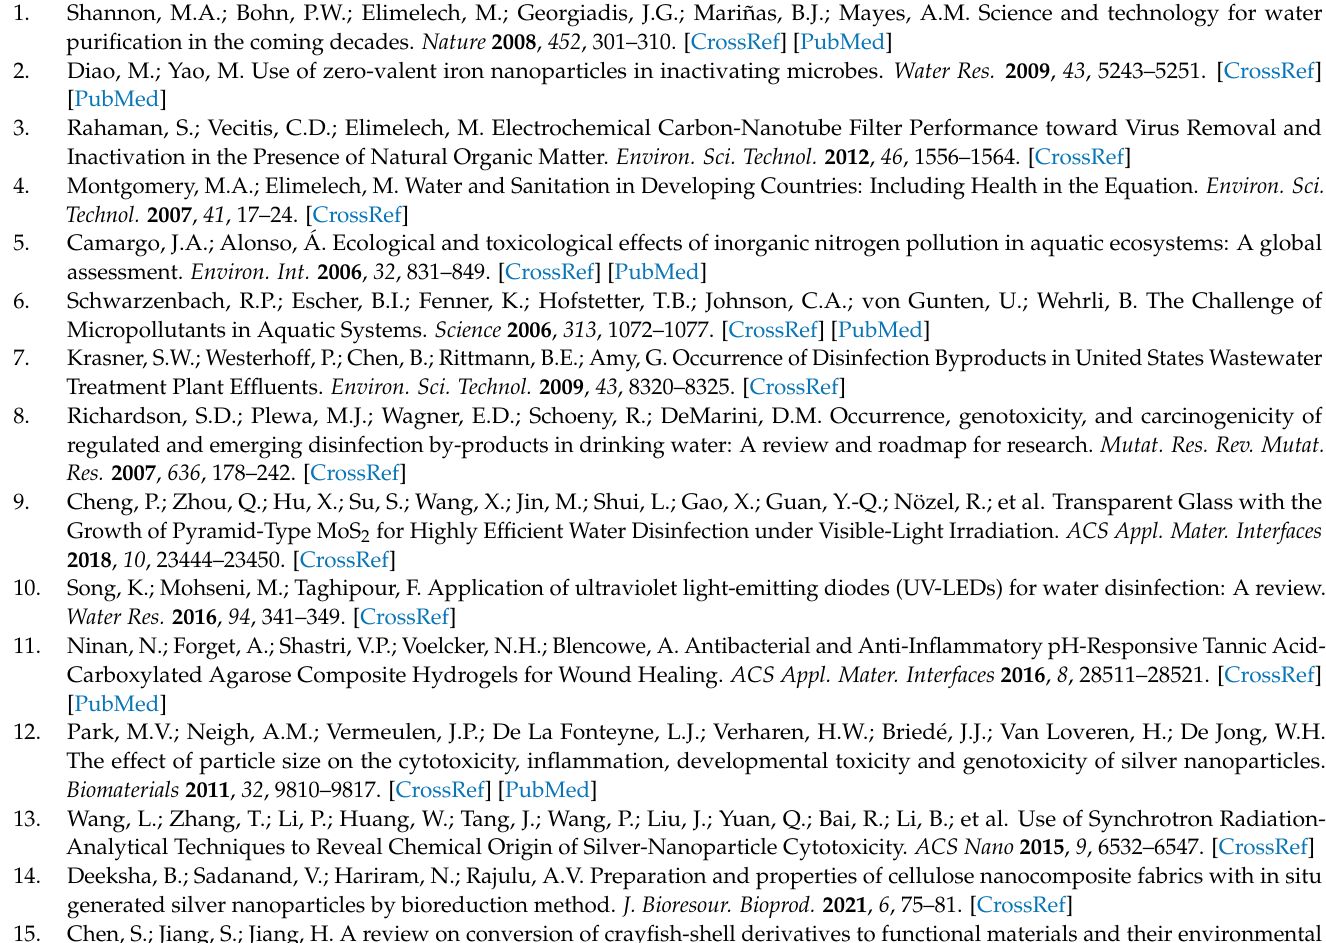
Figure S2. Column filled with R4 when in contact with the aqueous model of contaminated water (a) and after filtration (b). Figure S3. Variation in the Log 10 (CFU/mL) of E. coli 224 when exposed to R4 ( E. coli 224 (R4)) in a column imitating a sanitation system for 1, 2, 4, and 24 h of exposure vs. control ( E. coli 224). Figure S4. Percentage of the bacterial cells killed by R4 in a column imitating a sanitation system after 1, 2, 4, and 24 h of exposure when tested against E. coli 224. Table S1. Weights and cumulative weight loss (%) of R4 determined at times T 0 –T 7 . Table S2. Weights of R4 at times T 0 –T 3 and the cumulative swelling ratio